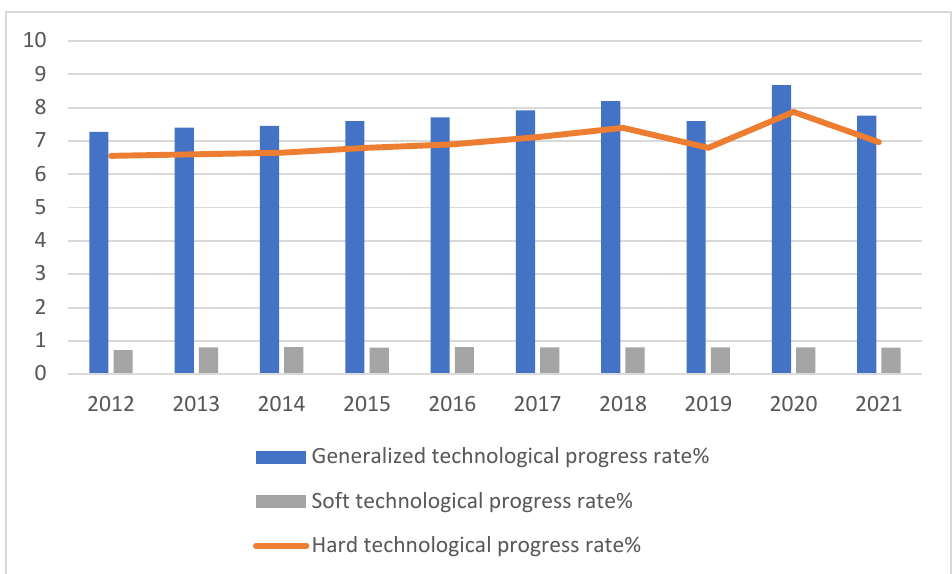
Figure 1. Trends of the technological progress rate. Table 5. Promotion of fishery science and technology in China from 2012 to 2020.